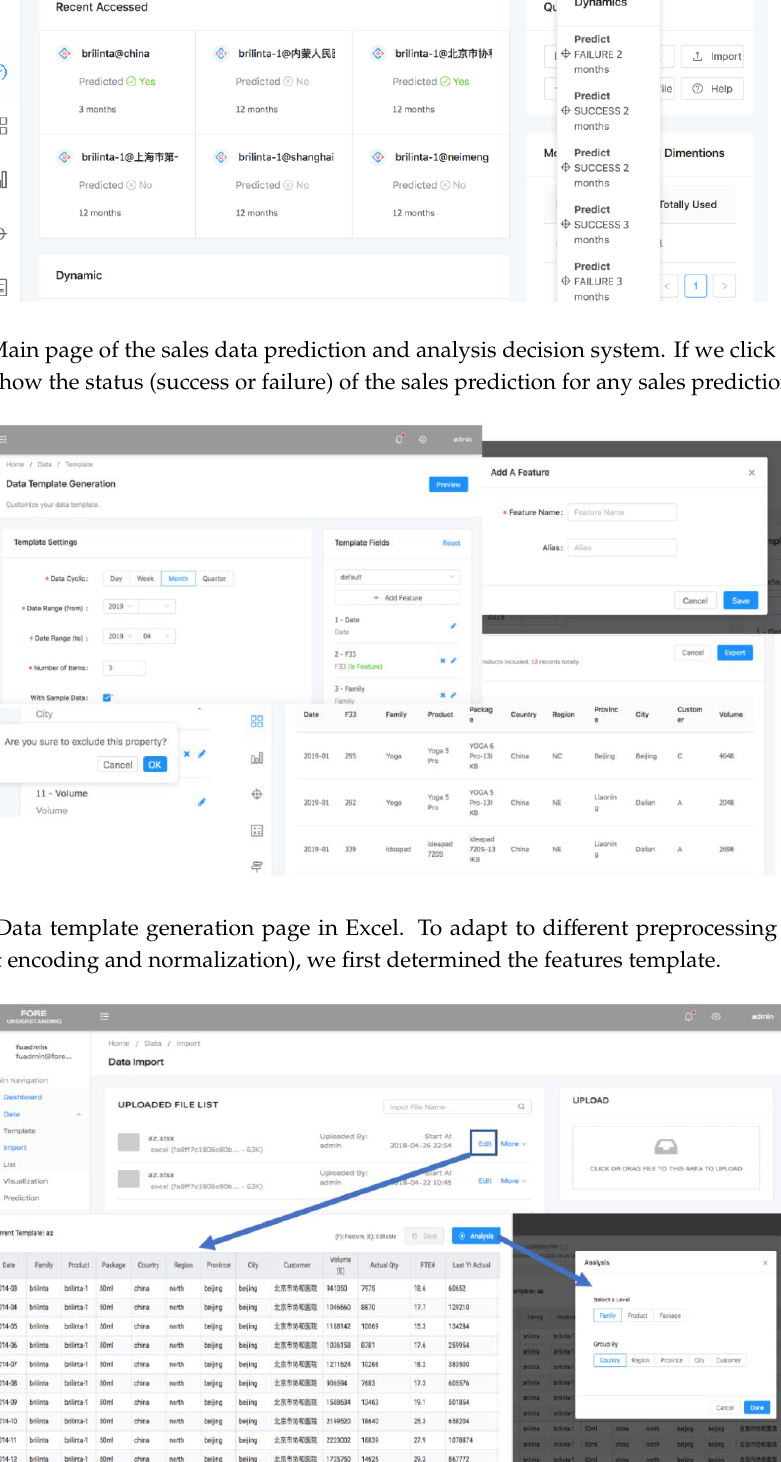
Figure A1. Home page of the sales data prediction and analysis decision system.